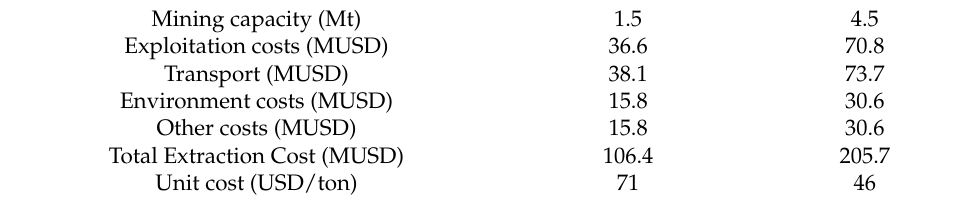
Table 5. Annual operating expenditures for the two extraction scales of raw